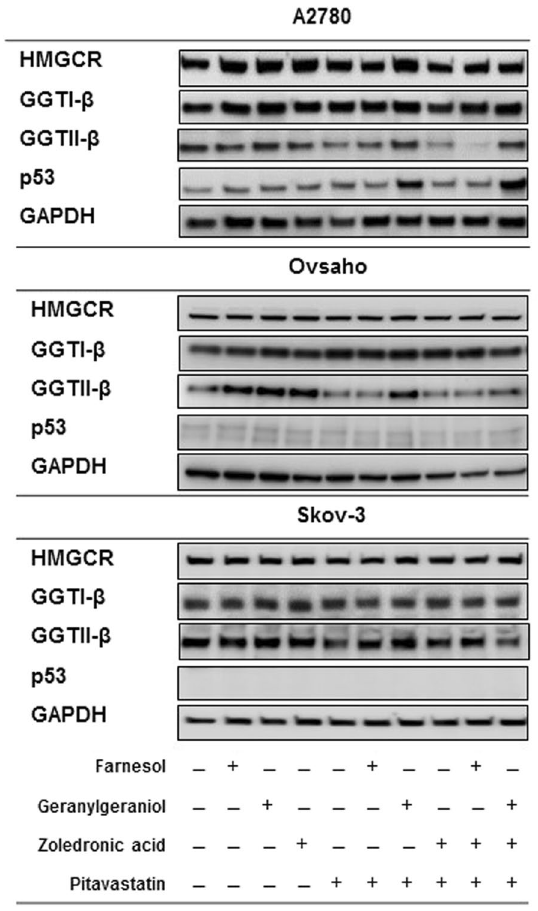
Figure 5. The effect of pitavastatin and pitavastatin-zoledronic acid on geranylgeranyl transferases. A2780, Skov-3 and Ovsaho cell lines were exposed to pitavastatin (1 µ M, 5 µ M and 1 µ M, respectively) and zoledronic acid (10 µ M) with and without geranylgeraniol (10 µ M) and farnesol (10 µ M) for 48 hrs. The levels of HMGCR, GGT-I β , GGT-II β and p53 were measured by immunoblotting of whole cell lysate. GAPDH was used as a loading control. The results are representative of 3